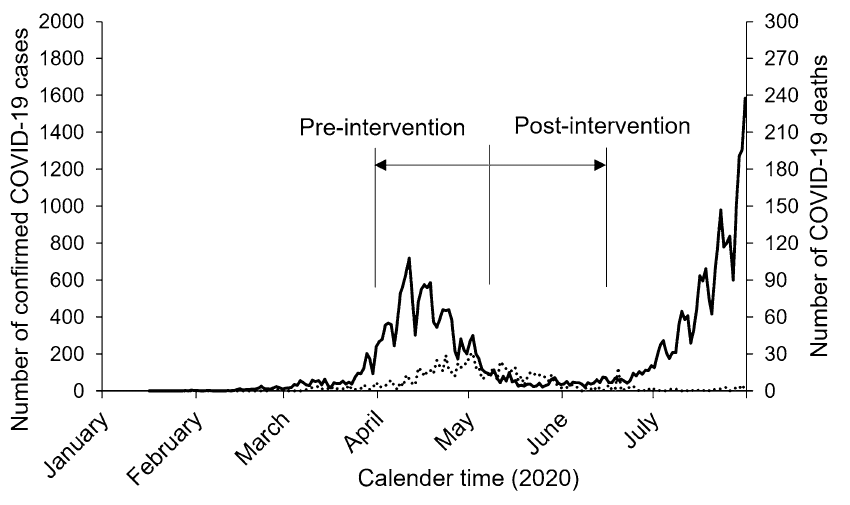
Figure 1. Temporal distributions of confirmed COVID-19 cases and deaths in Japan, January to July 2020. The horizontal axis shows the calendar date of reporting (all cases) and death (deceased individuals). All confirmed cases undertook RT-PCR testing during the corresponding time period. The left vertical axis represents the number of confirmed COVID-19 cases, and the right vertical axis the number of COVID-19 deaths. Within the panel, there are three solid vertical lines, showing the time period of our analysis. The left vertical line is the start date of the study period (1 April 2020), the center is the start date of improved diagnosis and treatment (8 May 2020), and the right is the end date of the study